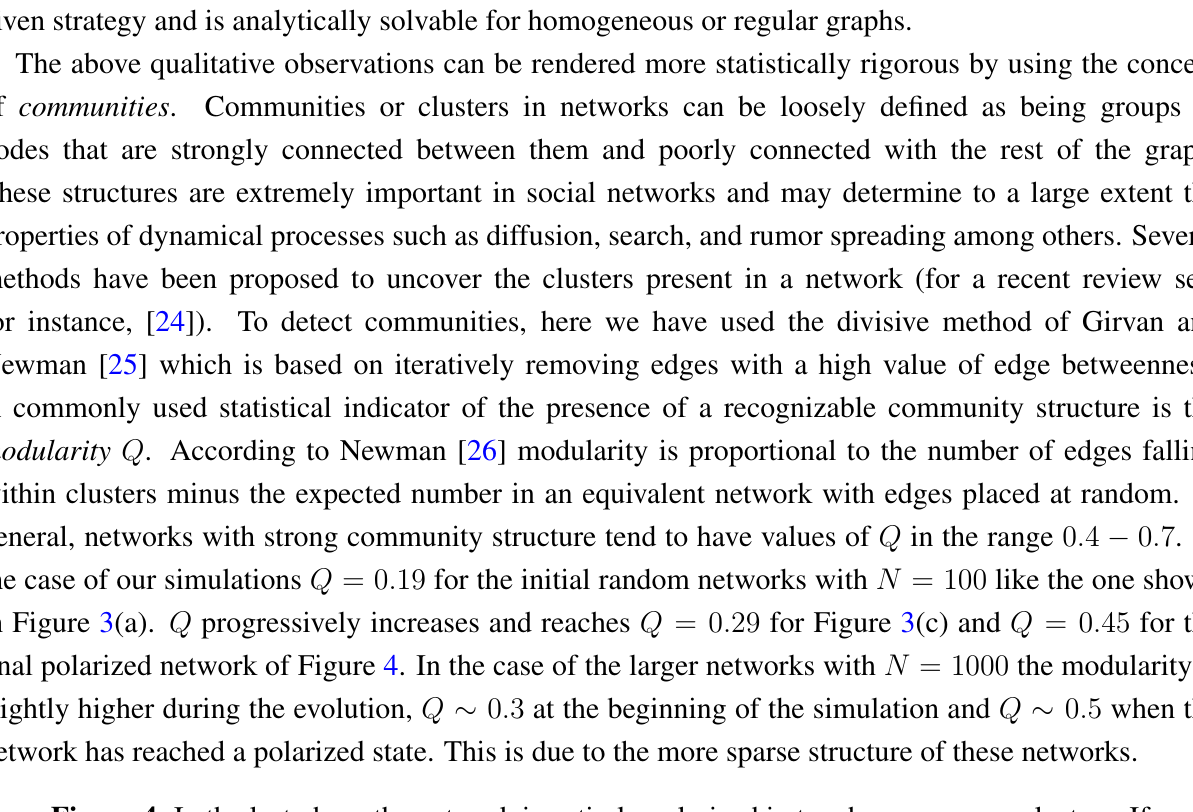
Figure 4. In the last phase the network is entirely polarized in two homogeneous clusters. If the simulation is long enough all the links between the two poles will